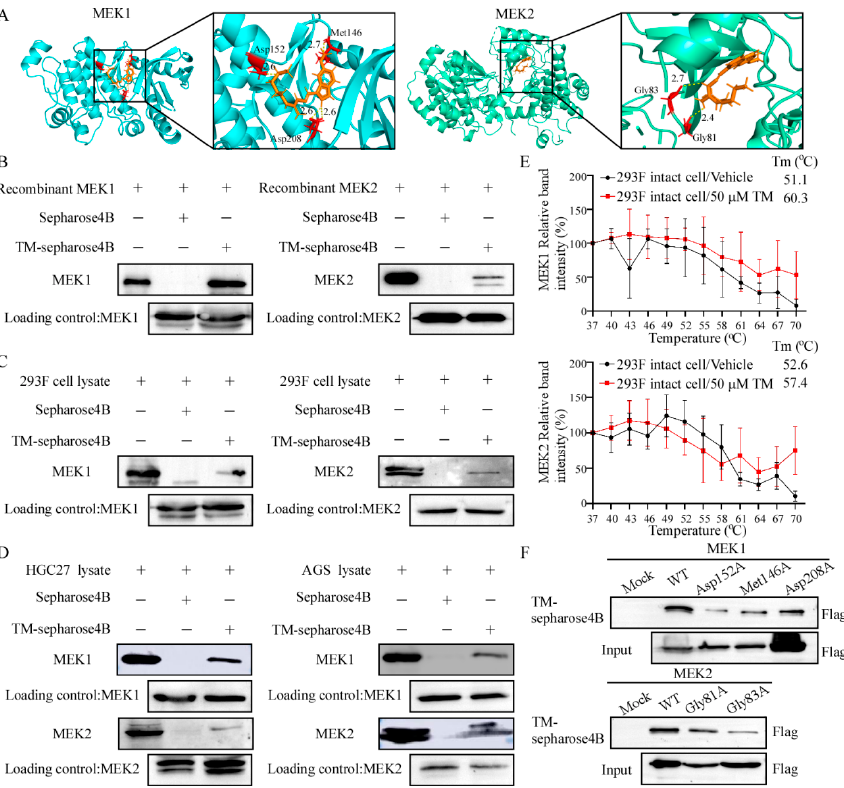
Figure 2. Tegaserod maleate binds to MEK1/2. ( A ) Computational docking model between tegaserod maleate and MEK1 or MEK2. The binding ability of tegaserod maleate to recombinant MEK1 and MEK2 protein ( B ), overexpressed MEK1 and MEK2 protein in 293F cells ( C ) and endogenic MEK1 and MEK2 protein in vitro ( D ), obtained via pull-down assay. ( E ) Cellular thermal shift assay. The protein stability of MEK1 and MEK2 in intact cells. ( F ) The binding ability of tegaserod maleate to mutant MEK1 and MEK2.